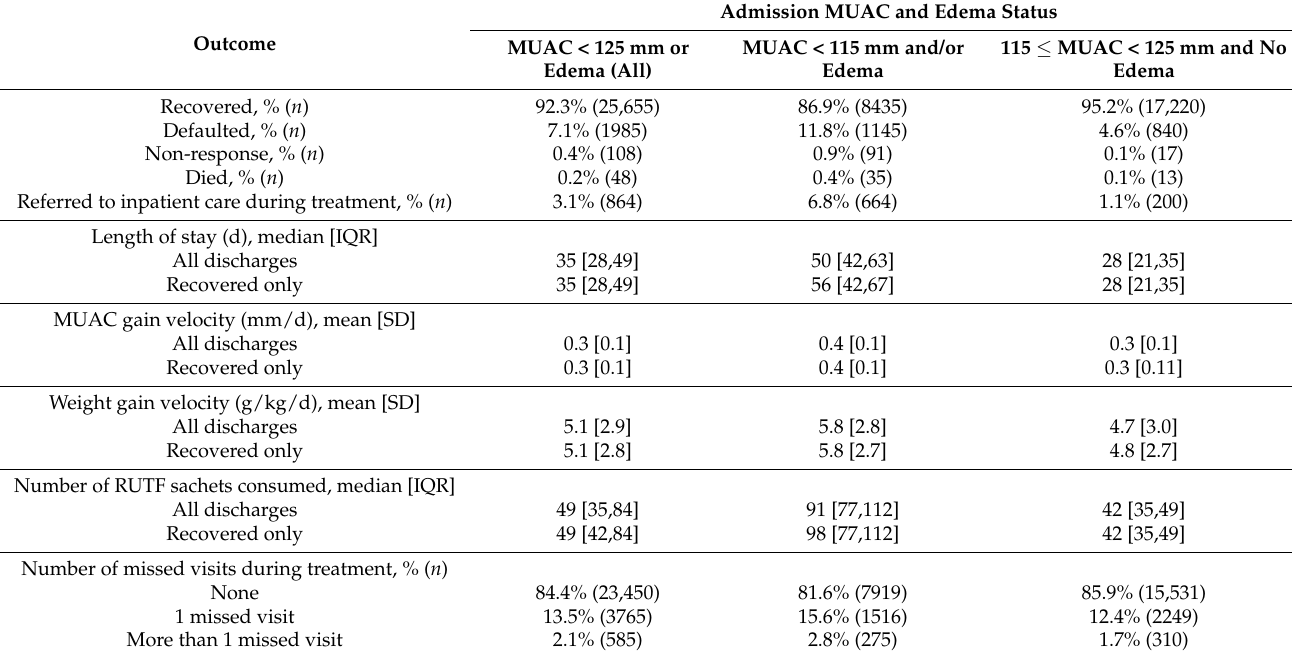
Table 3. Program outcome indicators for the simplified, combined treatment program in Mali.